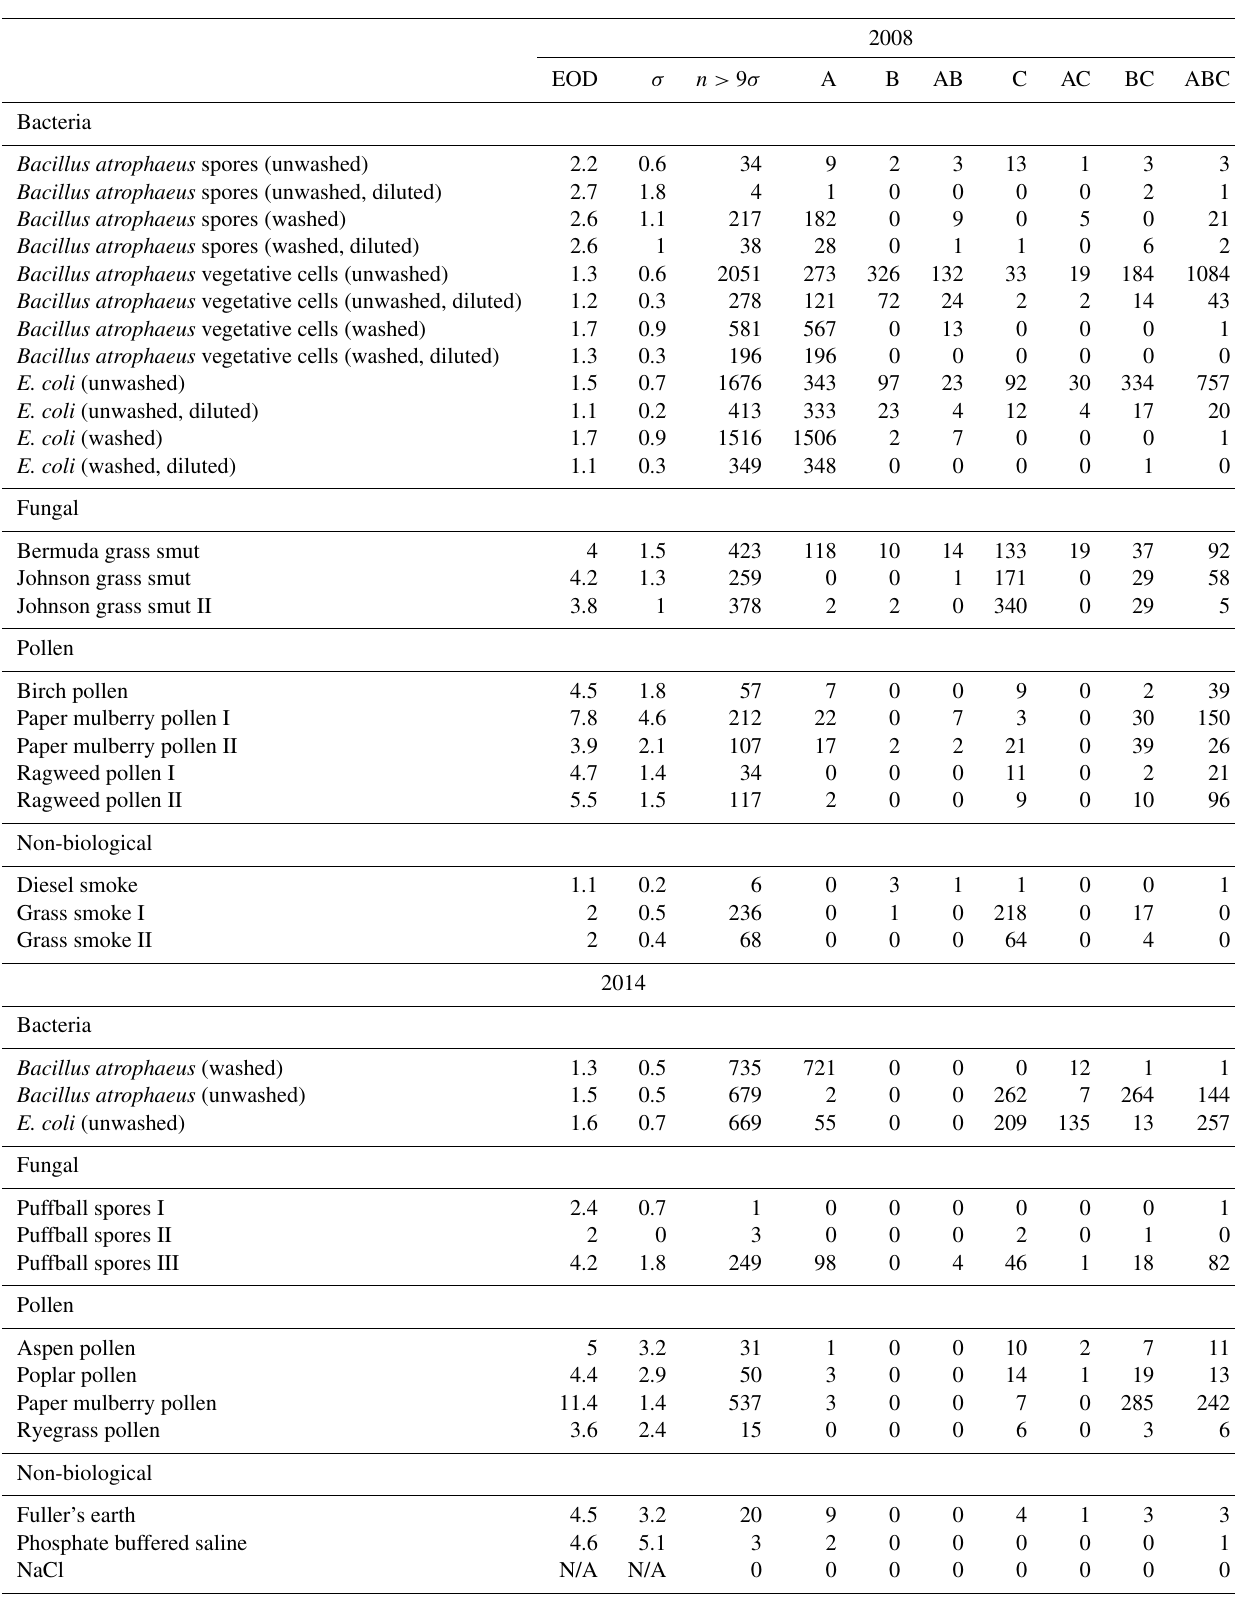
Table B3. Summary of properties for samples collected from 2008 and 2014, respectively, using a fluorescent threshold of 9 σ